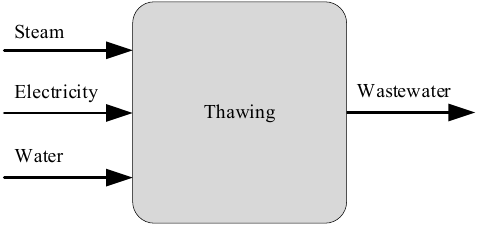
Fig. 1. Thawing process flow